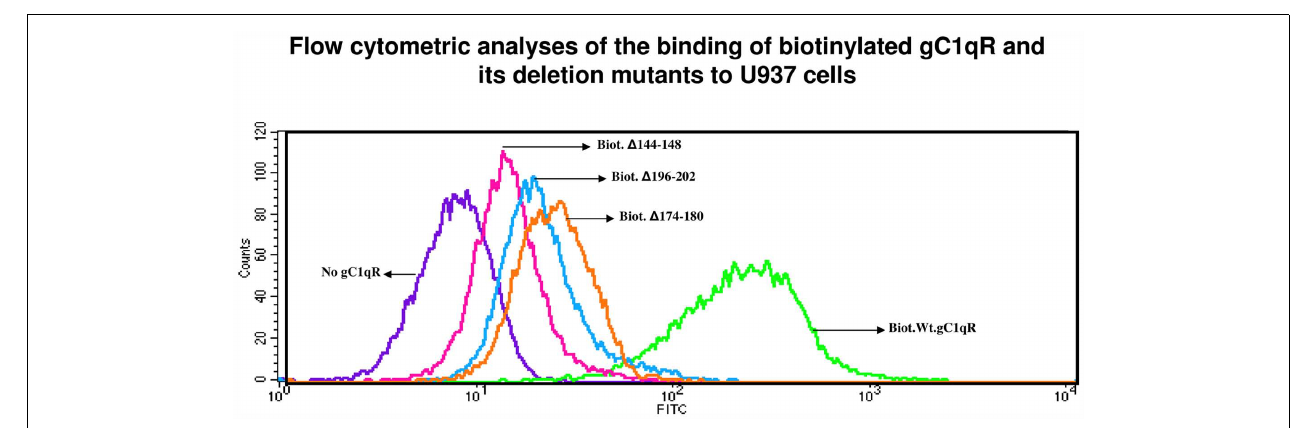
FIGURE 5 | Flow cytometric analysis of gC1qR and deletion mutants. Biotinylated gC1qR or gC1qR mutants were first incubated with U937 cells (10 6 /ml), and the bound proteins revealed by incubation with a predetermined